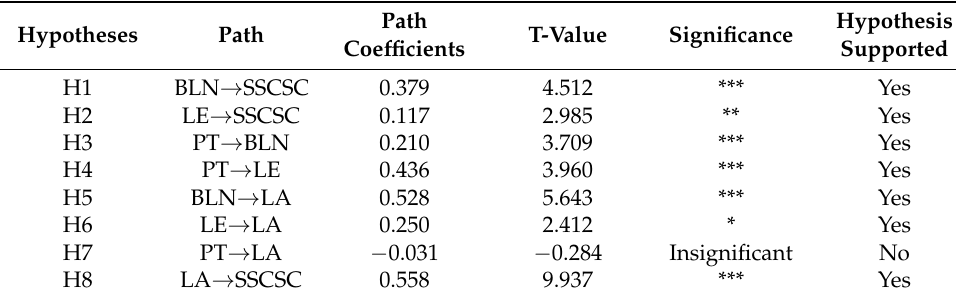
Table 6. Standard regression path coefficients of the SEM and hypothesis validation